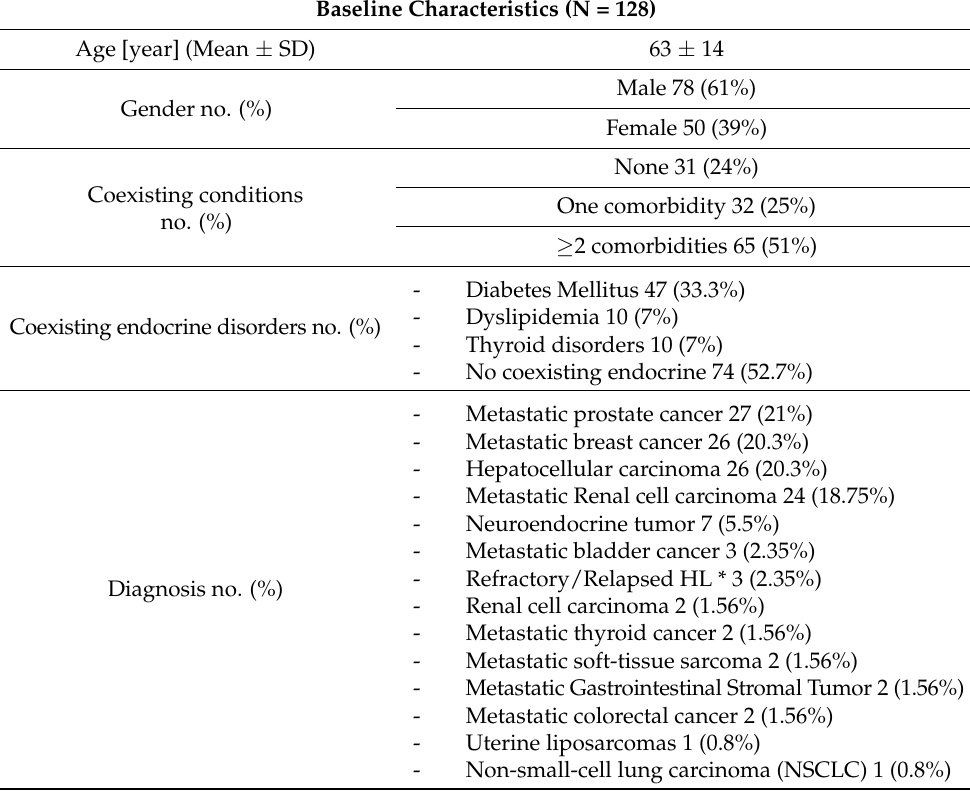
Table 1. Baseline Characteristics.